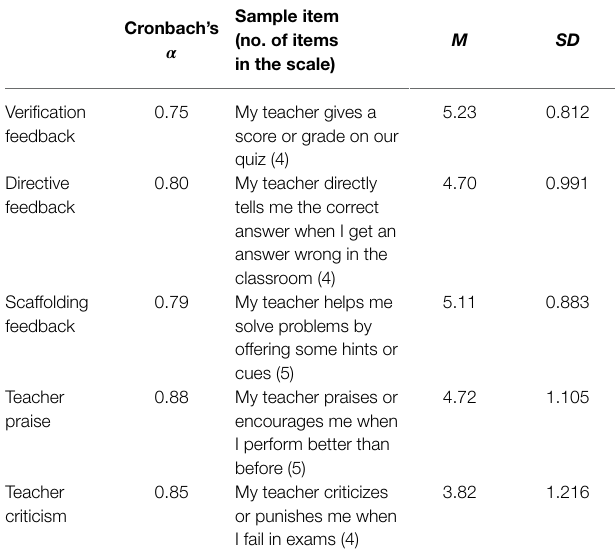
TABLE 2 | Sample items, internal consistency coefficients and descriptive statistics for the variables of students’ self-regulated learning measured in this